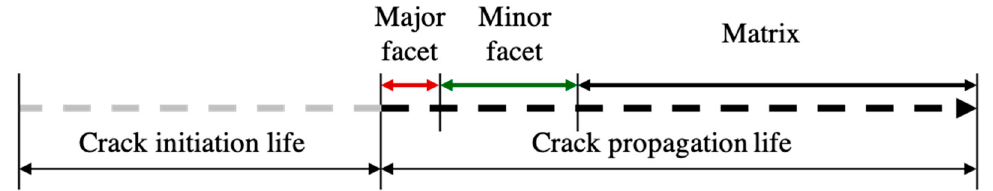
Figure 14. Fatigue life classification.